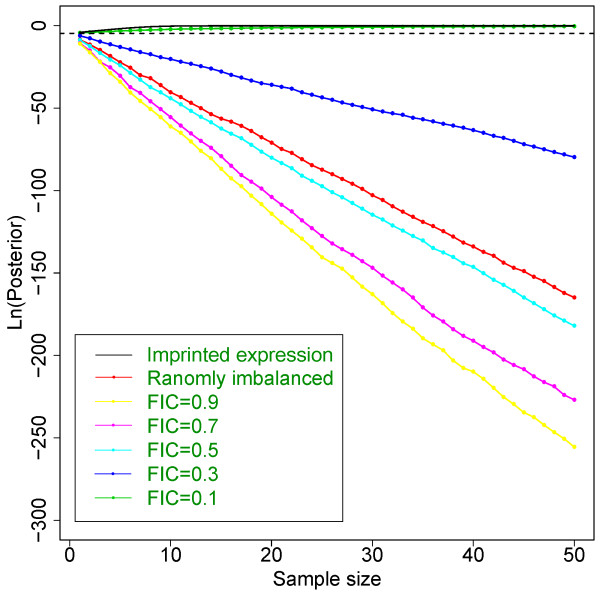
Effect of imbalanced transcript levels on the posteriors of biallelically expressed genes. Solid lines stand for simulated posteriors for imprinted genes (black line) and biallelically expressed genes (non-black lines). “Randomly imbalanced” means that in each sample we randomly picked one allele to have a lower expression level than the other allele. FIC indicates “Fixed Imbalanced Coefficient”, which means one allele is always expressed at a “FIC” level of the other one in all samples. The dashed line stands for the log-transformed prior. When FIC is low enough (typically <13%), posteriors are not able to tell the difference between imprinted (solid black line) and biallelic expression (green line).